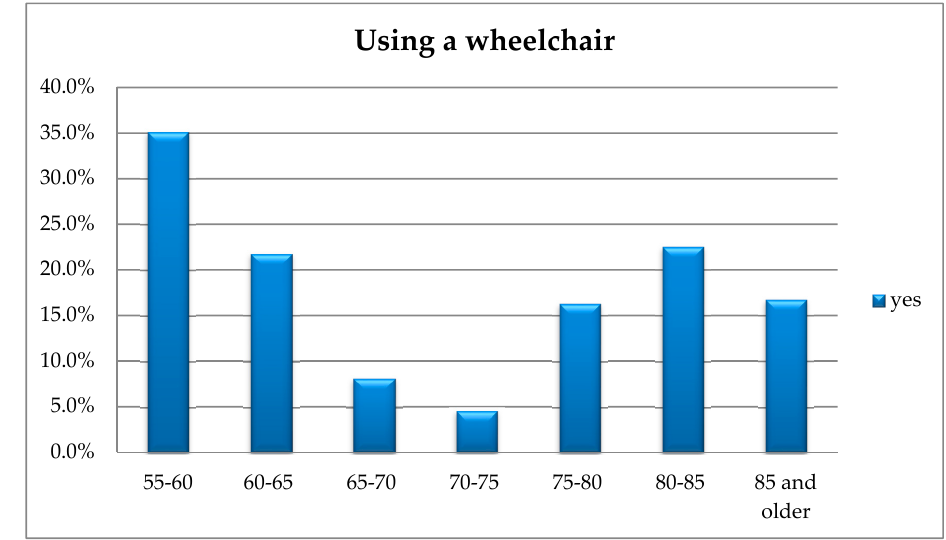
Figure 5. The respondents’ age vs. using a wheelchair.